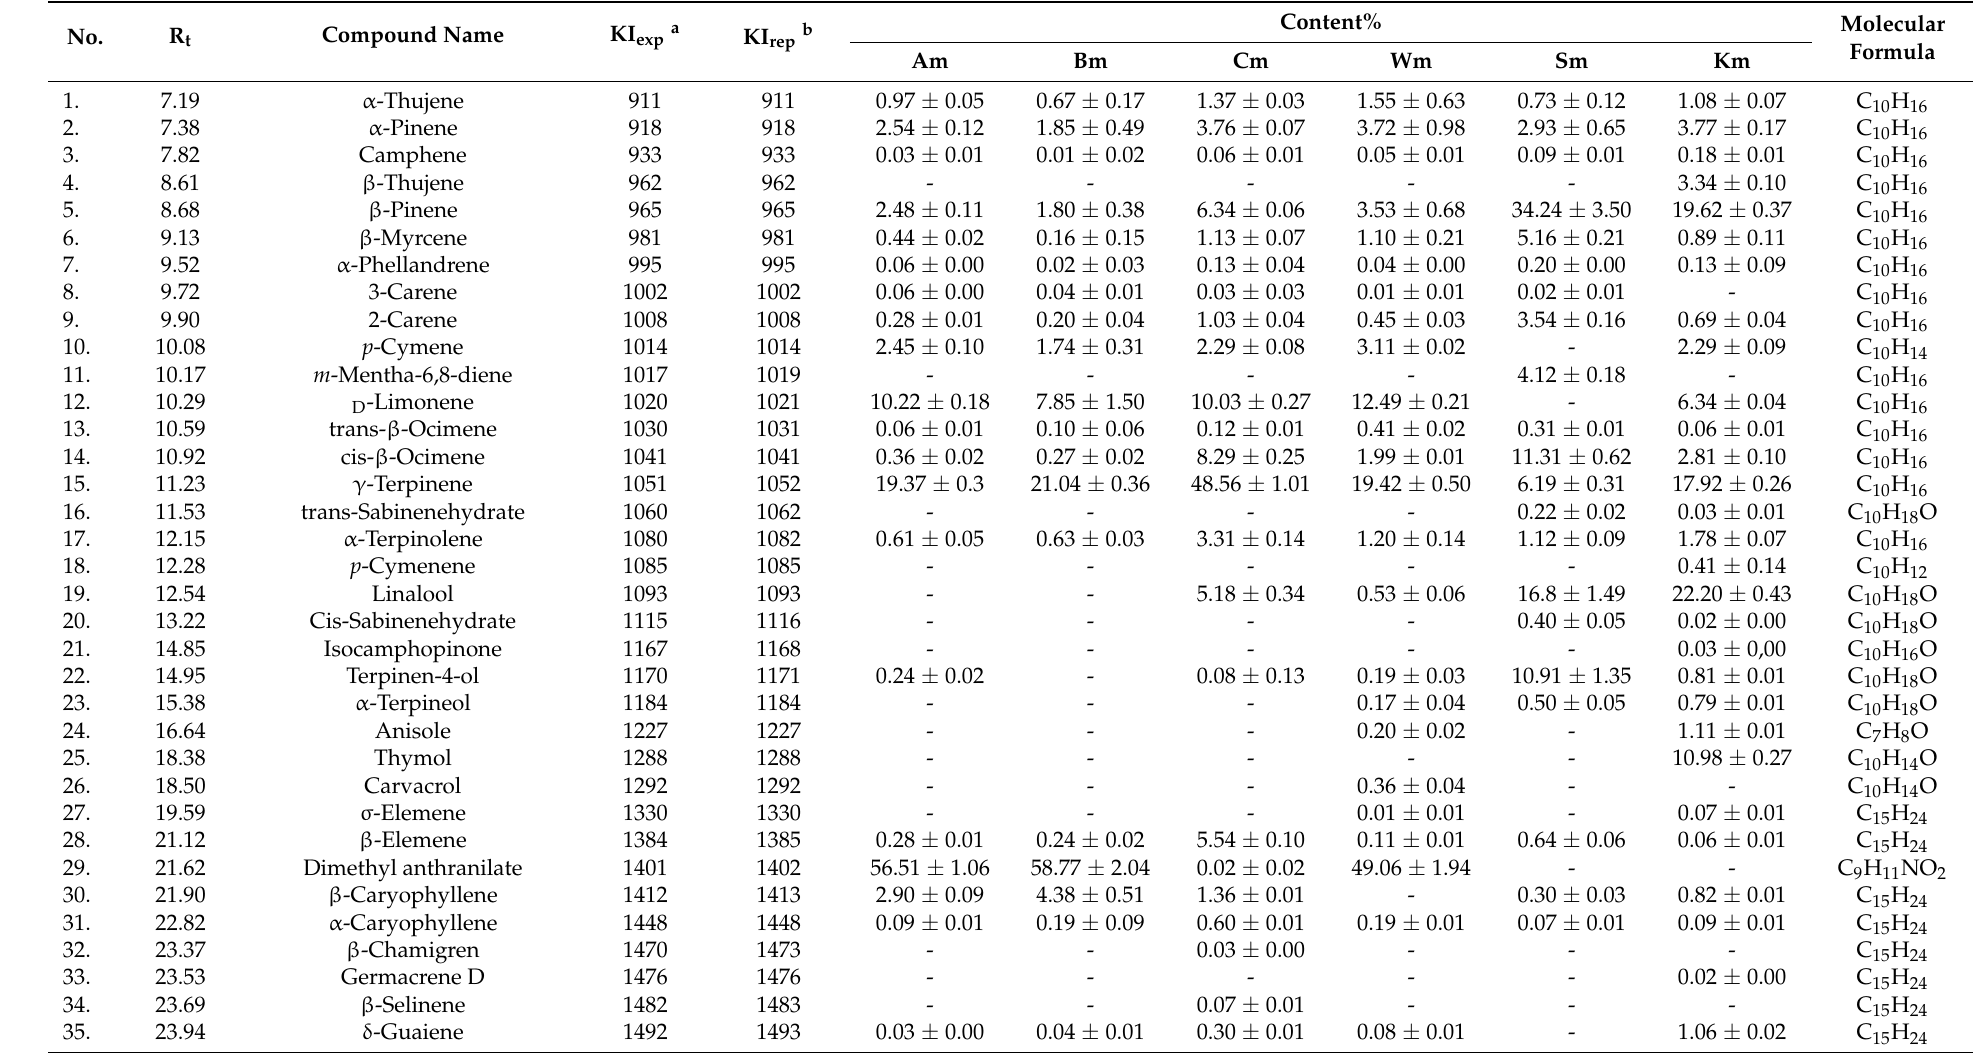
Table 2. Metabolic profiles of Citrus reticulata leaves cultivar EO by